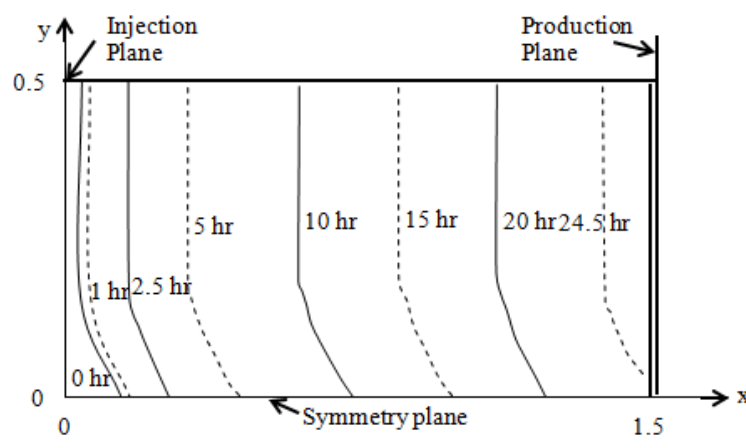
Figure 19. Schematic description of the problem: ( a ) conventional coordinate system; ( b ) immobilization coordinate system (redrawn from Abdel-Hadi and Hsu [8]).